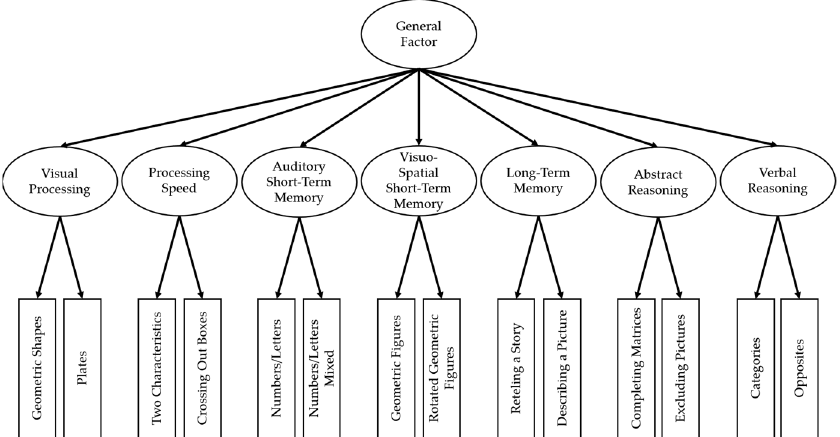
Figure 1. Theoretical Structure of the intelligence domain of the Intelligence and Development Scales-2 [22] with 14 subtests on Stratum I, 7 factors on Stratum II, and a general factor on Stratum III. Figure adapted with permission from Grieder and Grob [35].